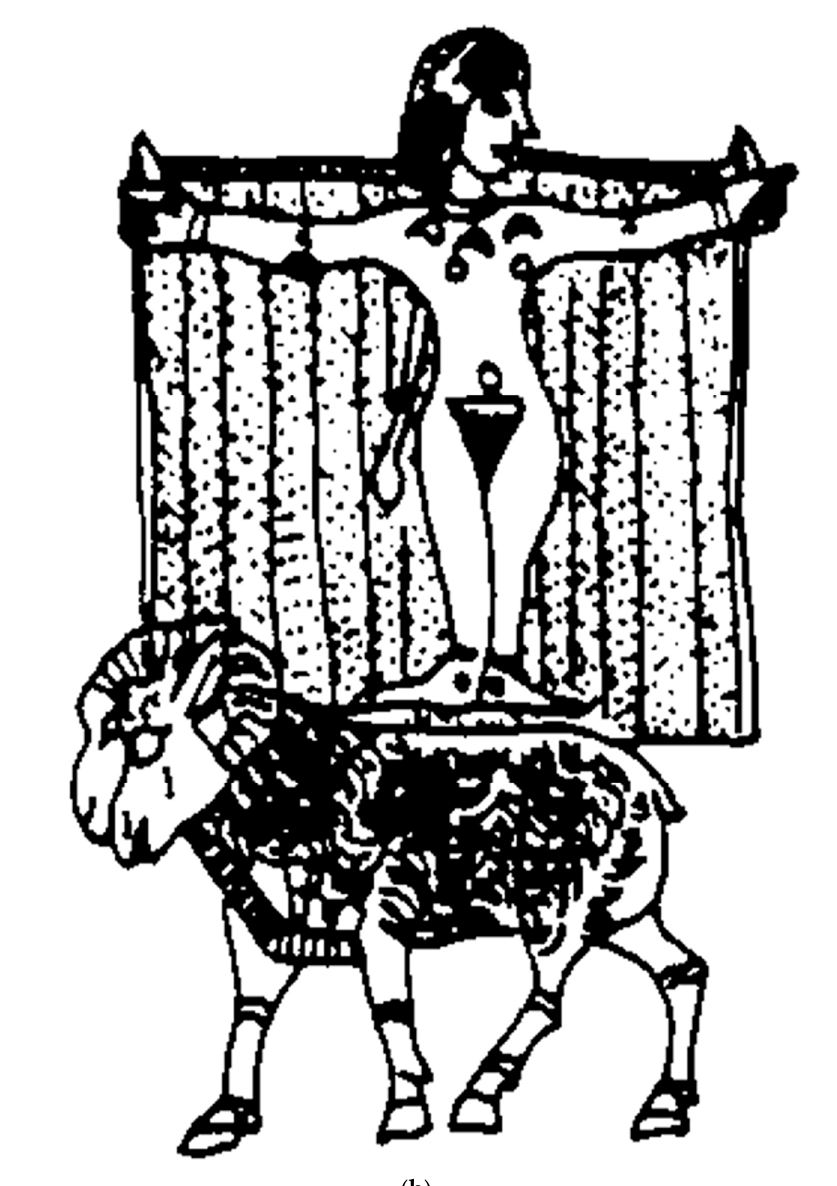
Figure 12. ( a ) Hasanlu gold bowl: rain drops connecting storm god and disrobing goddess (Winter 1989: Figure 6); ( b ) Hasanlu gold bowl, detail: rain goddess wearing three crescent